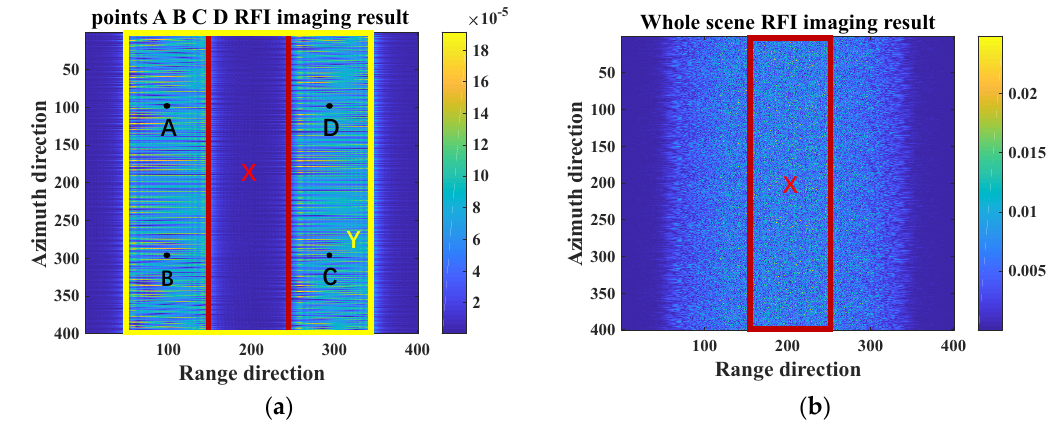
Figure 6. Results of BP algorithm. ( a ) point A, B, C, D; ( b ) the whole scene. Table 6. Power affecting a signal resolution cell from RFI.